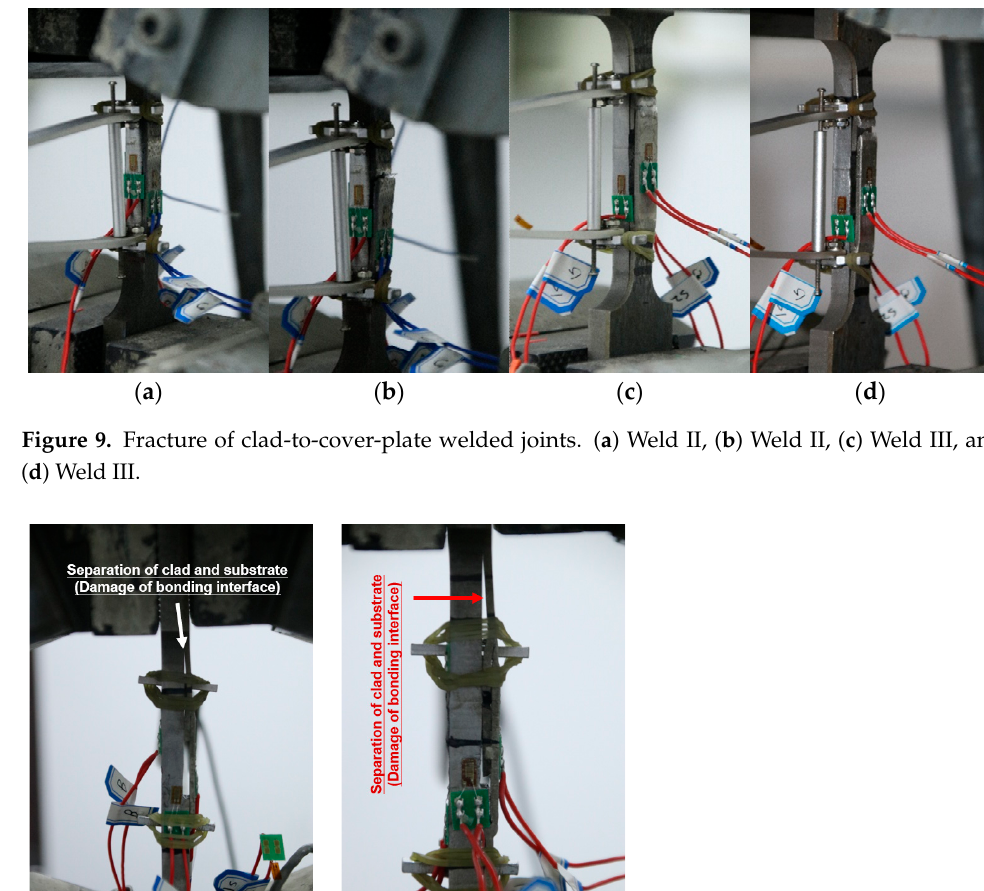
Figure 9. Fracture of clad-to-cover-plate welded joints. ( a ) Weld II, ( b ) Weld II, ( c ) Weld III, and ( d ) Weld III.